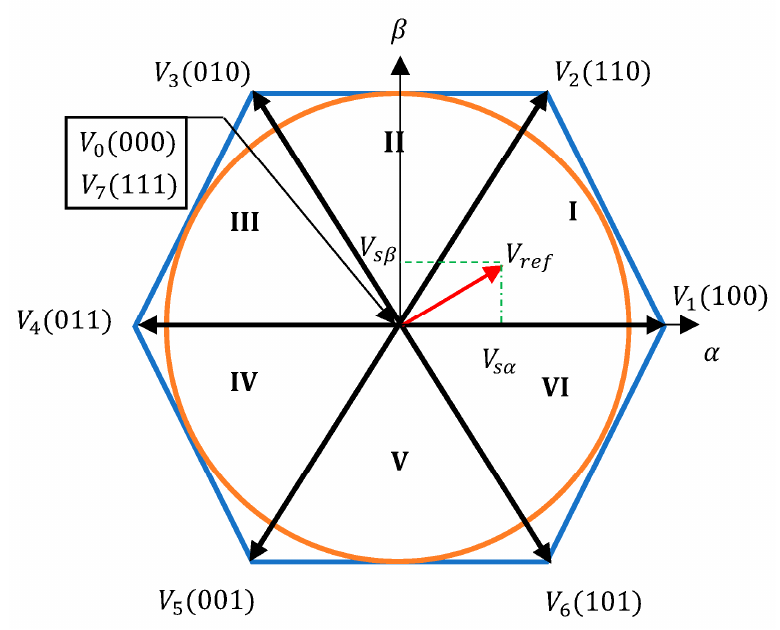
Figure 6. Diagram of voltage space vector.